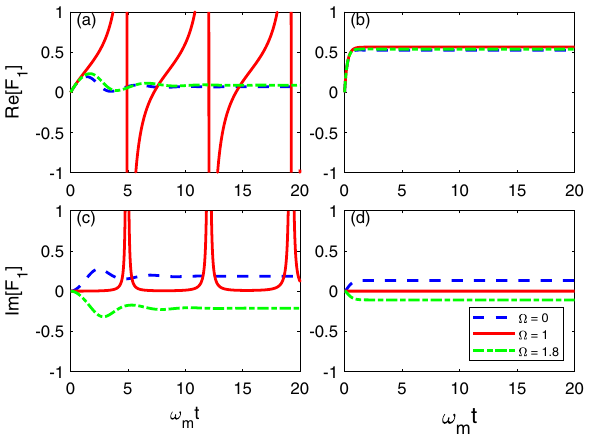
Figure 2. Evolution of the real ( a , b ) and imaginary ( c , d ) value of the complex coefficient function F 1 ( t ) in the ¯ O operator for Case I. In ( a , c ), γ = 0.5 . In (b) and (d), γ = 5.0 . Other parameters are chosen as: ω o = ω e = ω m , g om = g me = 0.1 ω m , Ŵ = 1